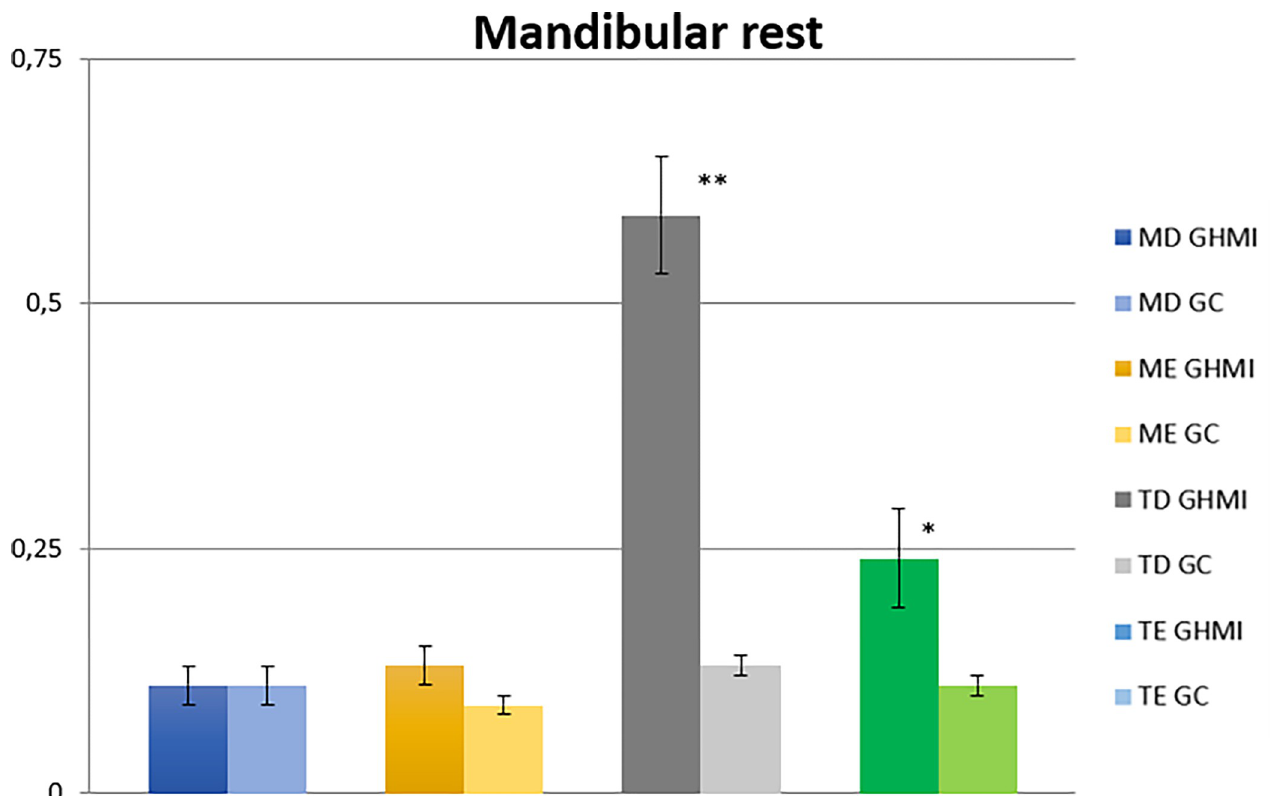
Fig 2. Normalized electromyographic means (RMS) in the mandibular rest condition for the right masseter (RM), left masseter (LM), right temporal (RT) and left temporal (LT) muscles, in the MIH (MIHG) and control (CG) groups. MIH, Molar-incisor